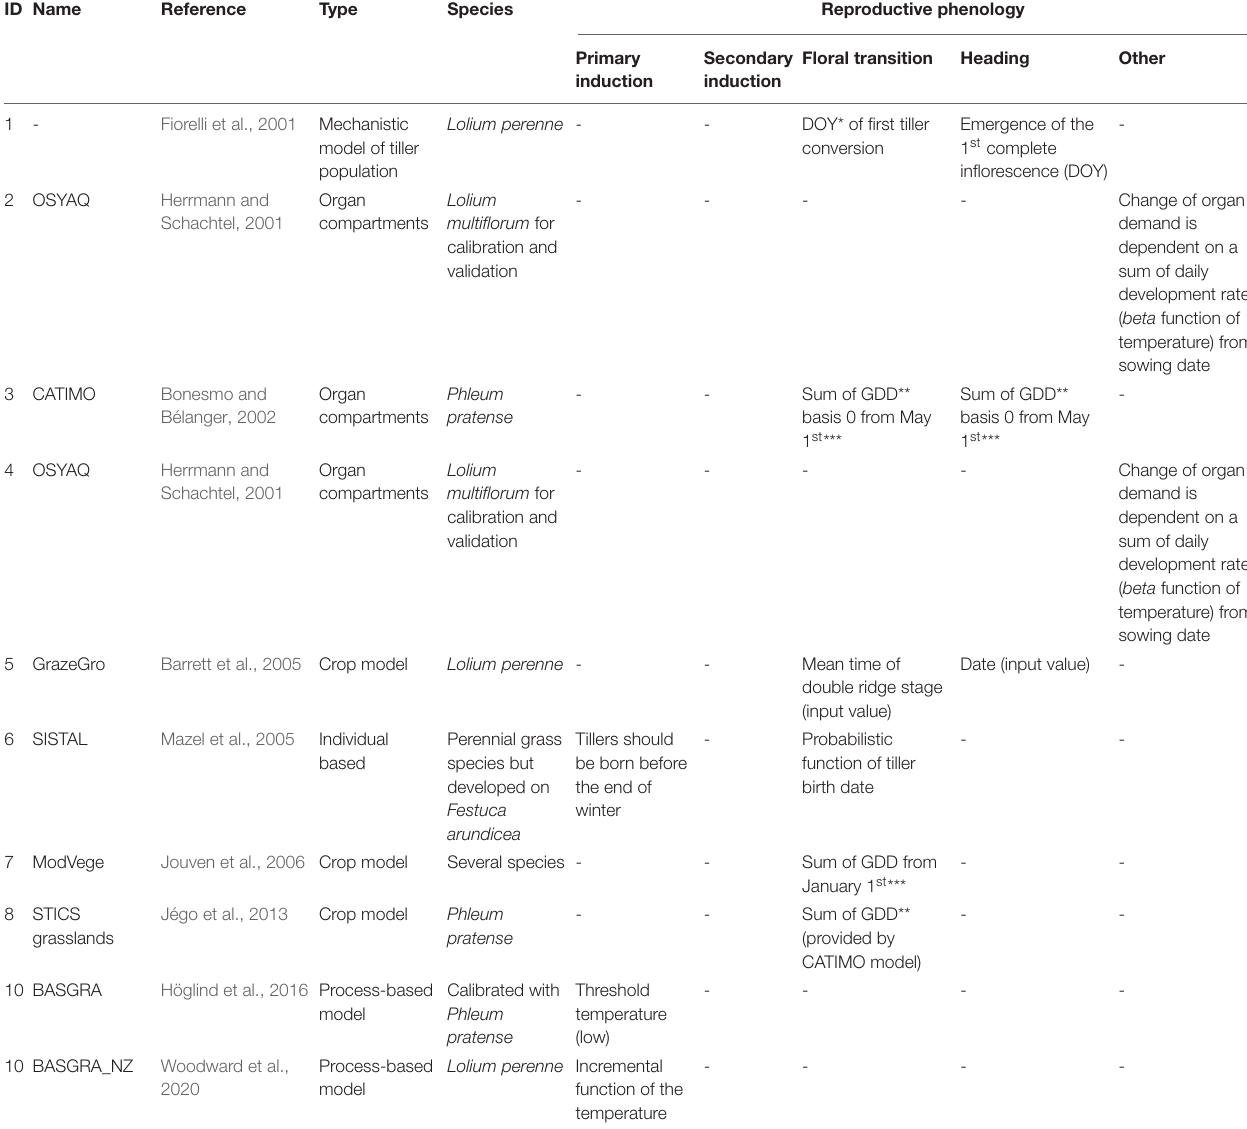
TABLE 1 | The reproductive phenology in current grassland